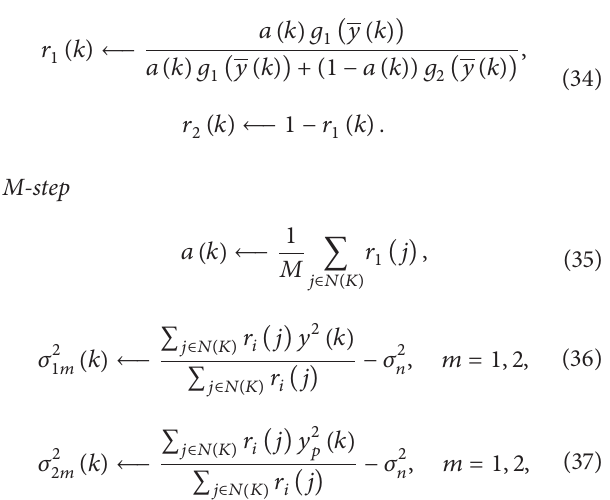
Figure 5: A shrinkage function produced from BiGaussRayMixSh- rink for sample